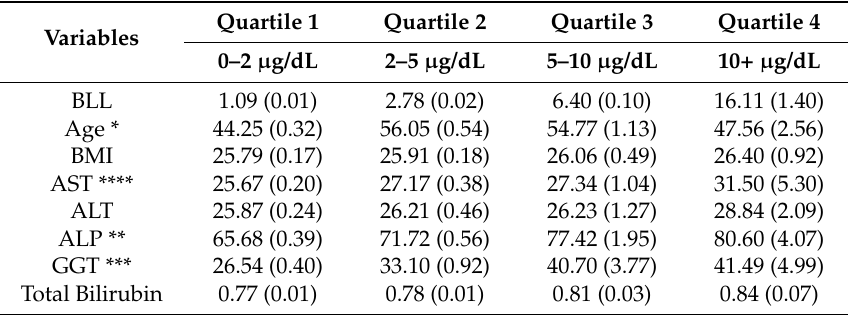
Table 4. Age and BMI and quartiles of